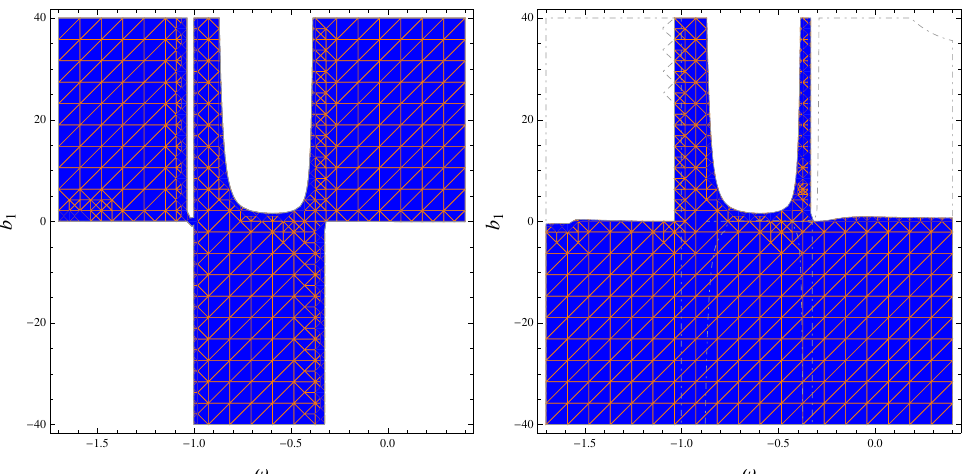
Figure 1. Stable modes of the ESU for λ = 2 (blue) and λ = 15 (orange), corresponding to closed universe model ( right ), and for λ 2 = 2 (blue) and λ 2 = 15 (orange), corresponding to the open universe model ( left